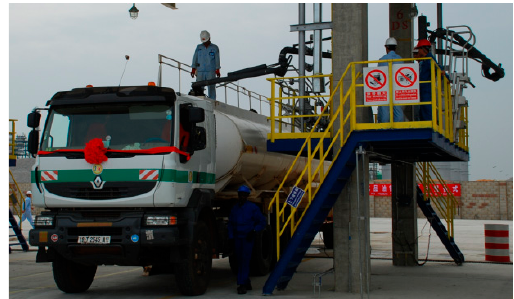
Figure 1. Tank car top loading.